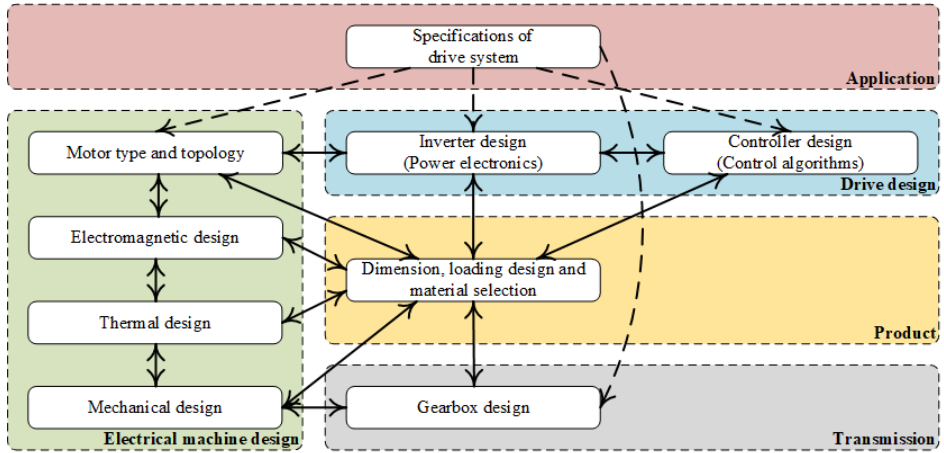
Figure 9. Complex framework of electrical drive system-level design